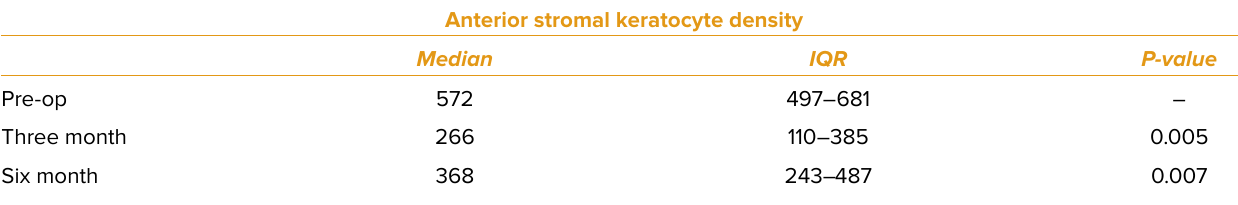
Table 1. Quantitative analysis of anterior stromal keratocyte density before and after hypotonic collagen